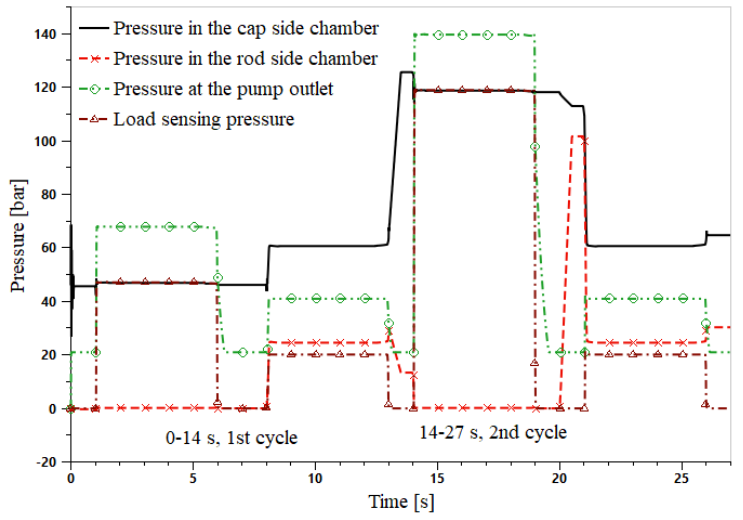
Figure 9. Boom cylinder and pump pressure curves in the original system.